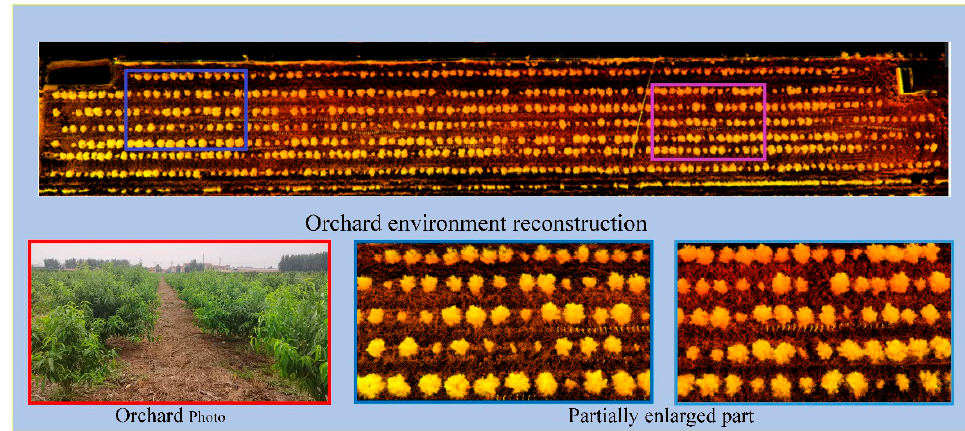
Figure 4. Natural environment photos and point cloud maps.